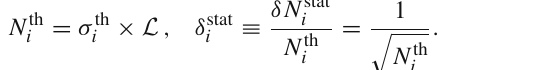
(relative) statistical uncertainty δ stat